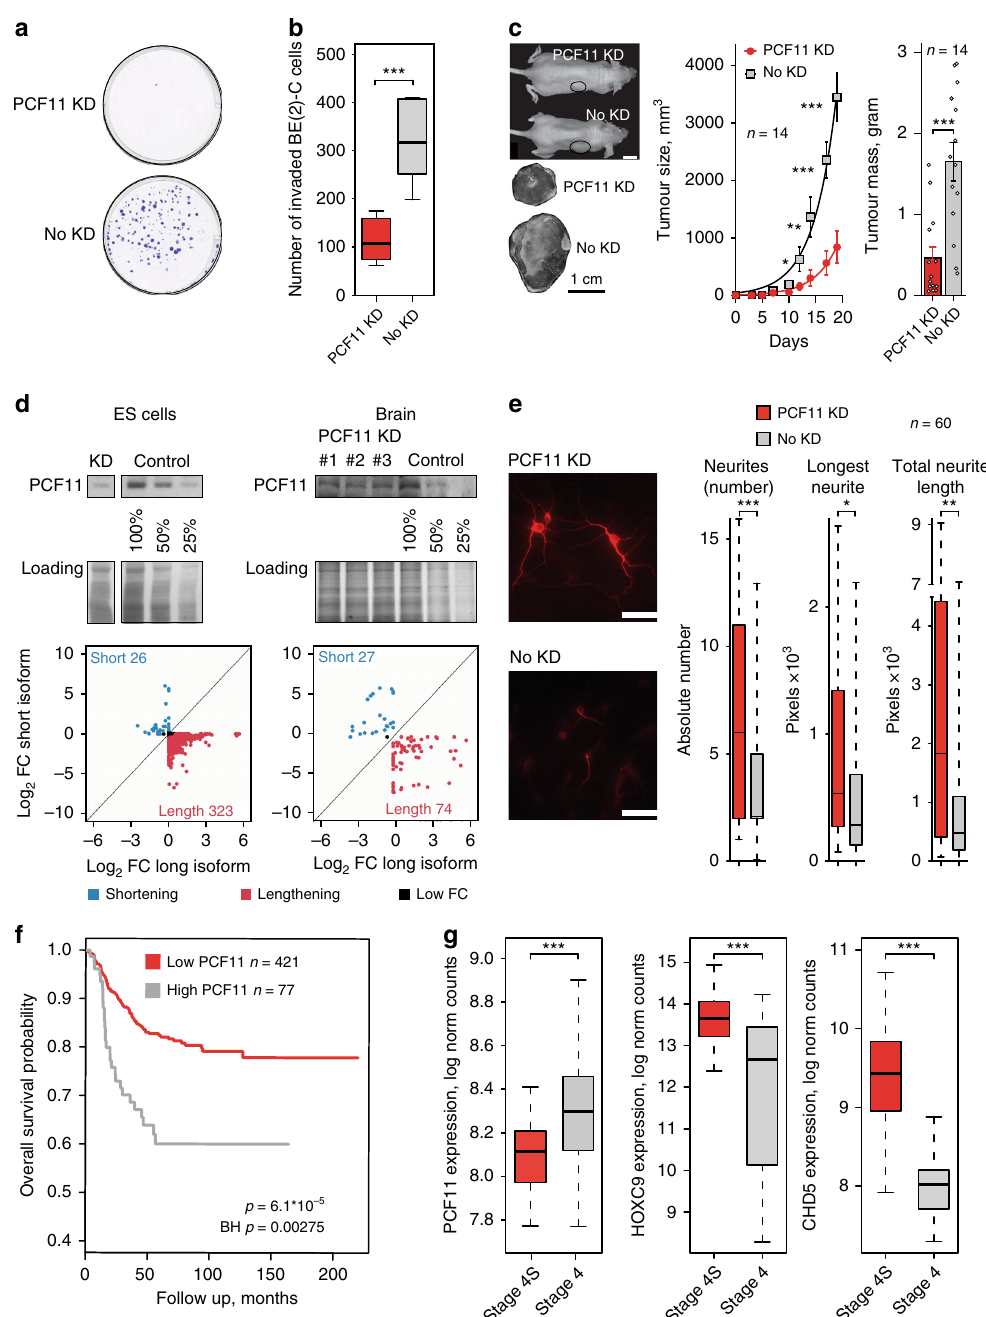
Fig. 5 PCF11 orchestrates neuroblastoma progression and neuronal differentiation in vitro and in vivo in mice and neuroblastoma patients. a Colony formation and b matrigel invasion assays of BE(2)-C cells with and without depletion of PCF11. c Neuroblastoma xenograft transplantation model with and without depletion of PCF11 (mean ± s.e.m., one-sided t -test p -value; scale bars 1 cm). d In vivo effect of PCF11 depletion on TREND in murine ES cells and in neuronal tissues obtained from a mouse model transgenic for a TET-inducible PCF11-shRNA. e Differentiation phenotype of murine neuronal precursors (E18) with and without doxycycline-induced depletion of PCF11 (scale bar 100 µ m; cells are stained with an antibody directed against TUBB3 (red)). f Kaplan-Meier curve showing low PCF11 expression being associated with higher survival rate in neuroblastomas (BH-adjusted p -value, log-rank test, GEO GSE49711 44 ). g Low-level PCF11 expression in patients with spontaneously regressing stage 4S ( n = 48) compared to fatal stage 4 ( n = 65) neuroblastoma tumours. High-level expression of neuroblastoma regression markers in stage 4S ( n = 48) vs. stage 4 ( n = 65) neuroblastoma tumours (HOXC9 46 p = 2.3 × 10 − 8 and CHD5 47 p = 2.8 × 10 − 18 ), con fi rming validity of patient cohorts (two-sided t -test p -values; GSE49710 44 , for comparison of PCF11 expression in spontaneously regressing stage 4S with low-risk neuroblastoma tumours (i.e. stage 1 and 2) see Supplementary Figure 7d). For box plots, centre line depicts median, hinges show 25th and 75th percentile, whiskers depict interquartile range (IQR = 1.5). * p < 0.05, ** p < 0.01, *** p <